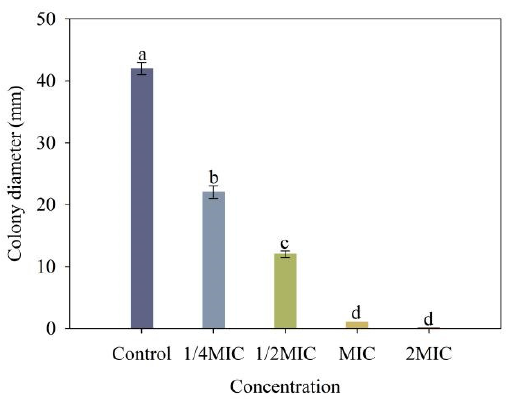
Figure 7. Effect of different concentrations of 4-allylbenzene-1,2-diol on swimming motility of Xoo. Note: Different lowercase letters show the significant difference at p < 0.05 level using Duncan’s new multiple range test.